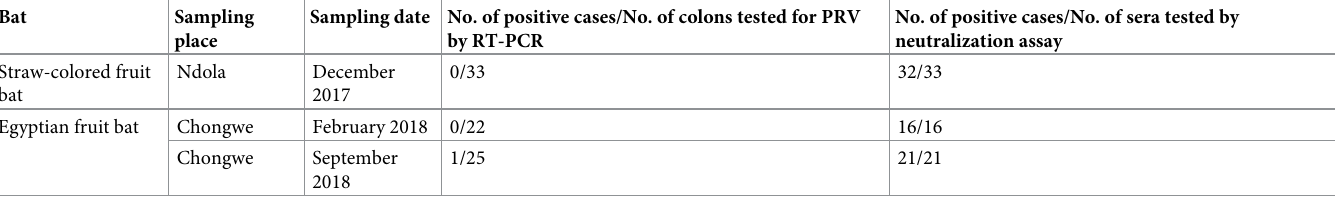
Table 1. Summary of bat samplings and screening results of RT-PCR and neutralization test. Bat